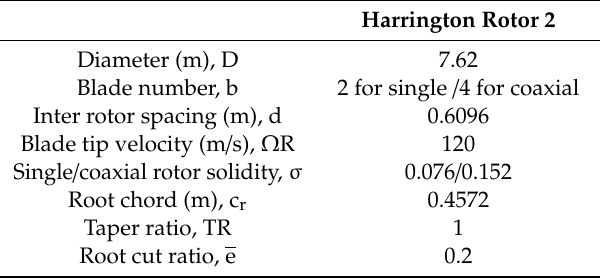
Table 1. Major information of rotors in the experiments by Harrington [4].